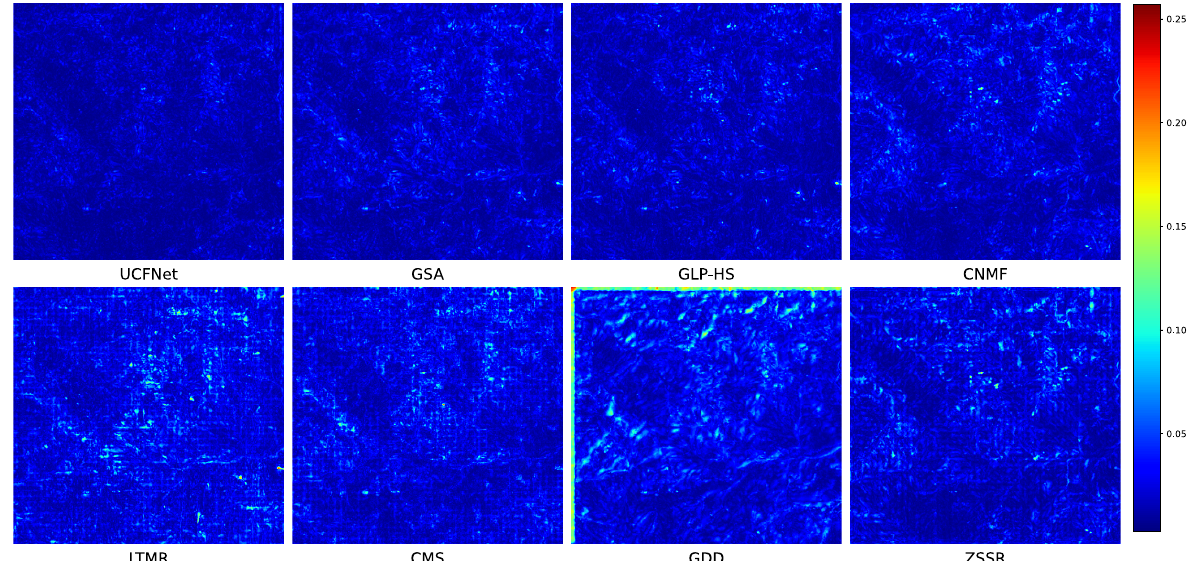
Figure 5. Error maps, AVIRIS-NG-Cuprite dataset, the scaling factor is 8.